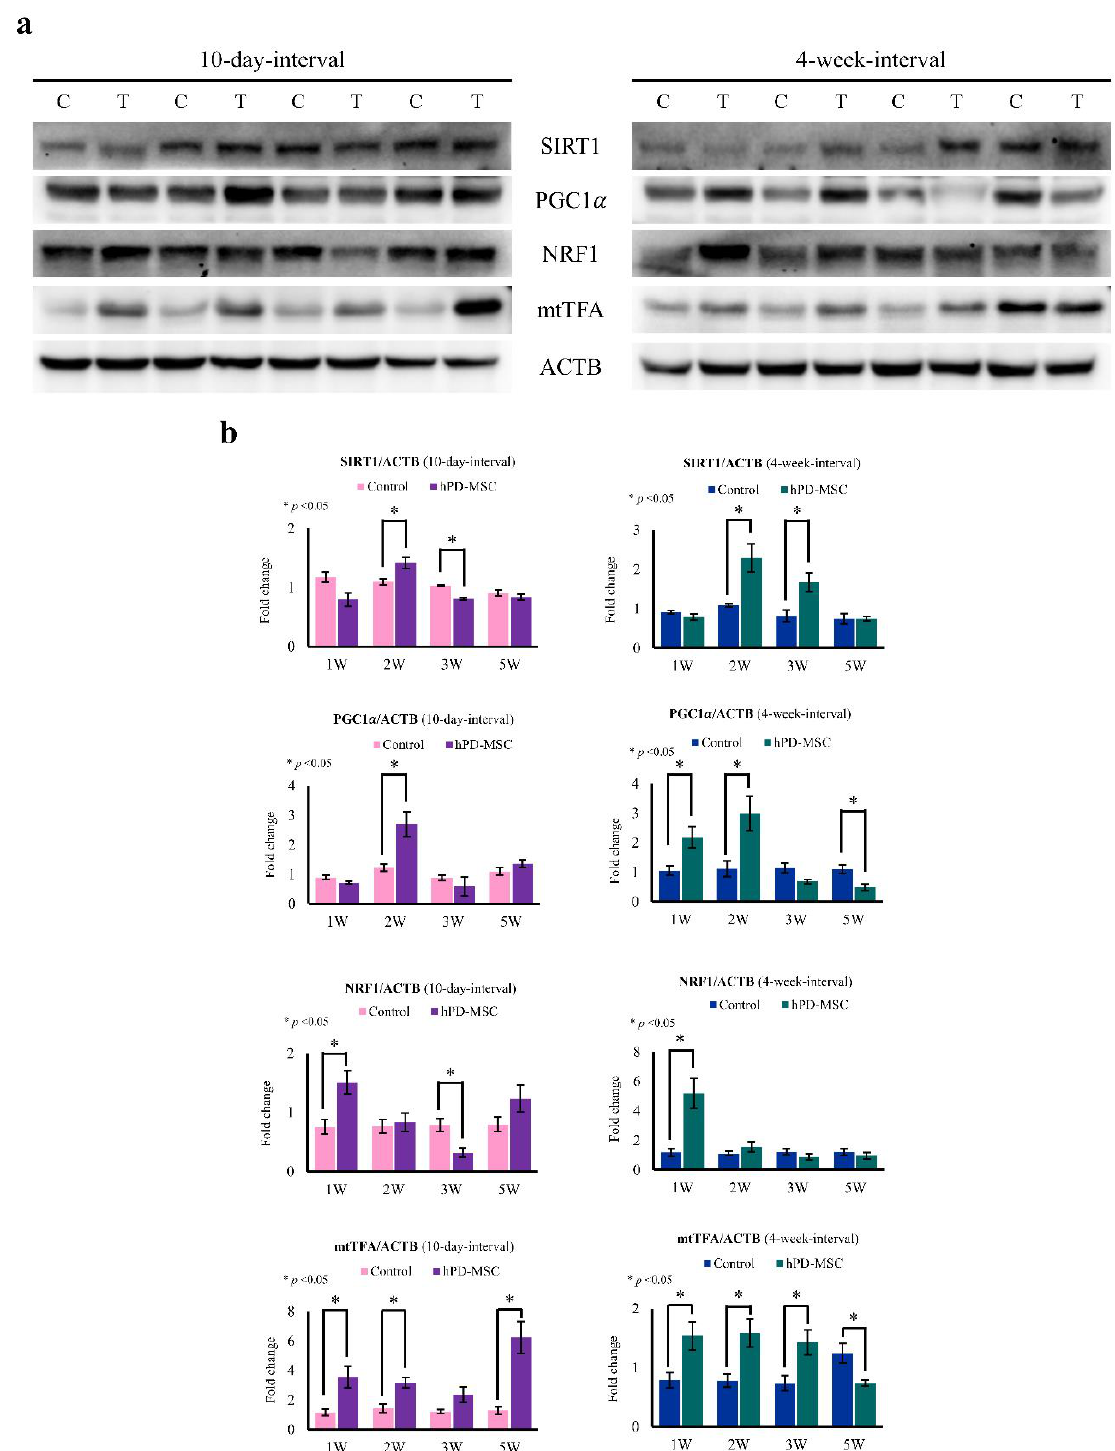
Figure 5. Multiple injections of hPD-MSC therapy enhanced mitochondrial biogenesis in the liver. ( a ) Protein expression of the mitochondrial biogenesis markers SIRT1, PGC1 α , NRF1, and mtTFA at 10-day intervals or 4-week intervals was investigated using Western blot analysis. ACTB was used as a loading control. C, control group; T, multiple-injection hPD-MSC therapy group. ( b ) Bar graph represents the band intensity of each marker normalized to the intensity of the respective ACTB band. Data are presented as the mean ± SEM. The asterisk represents statistical significance at p < 0.05. Control, PBS-injected group; hPD-MSCs, multiple-injection hPD-MSC therapy group.